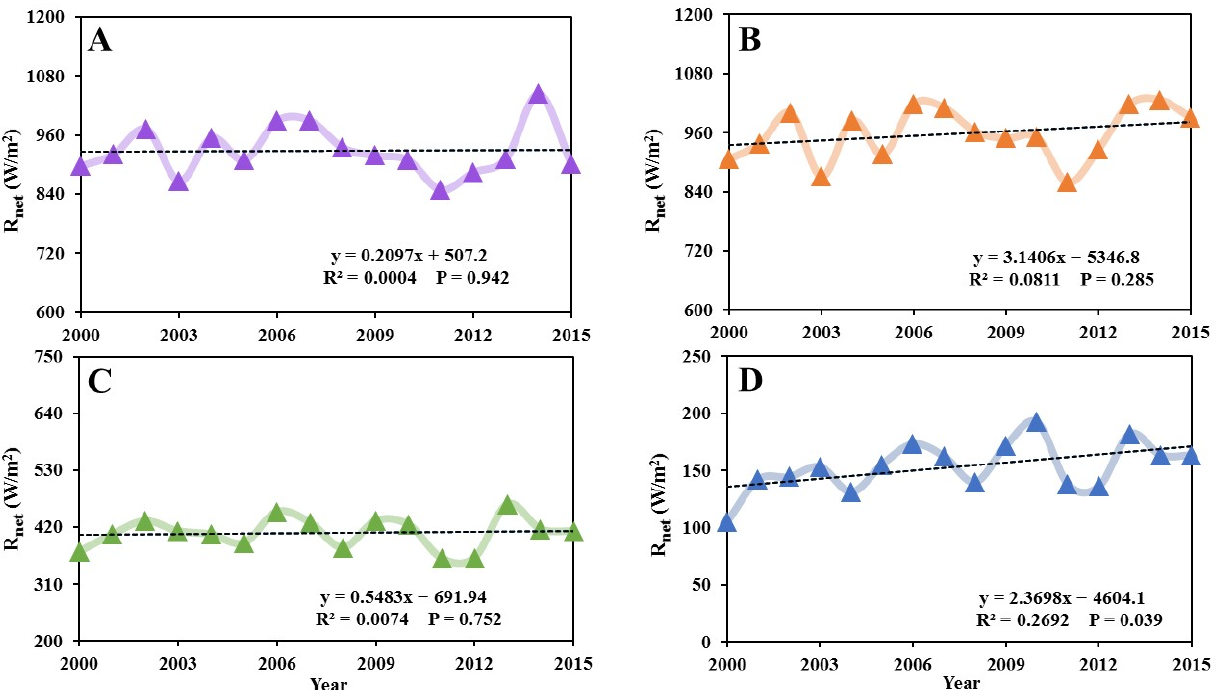
Figure 14. Trend of net radiation from 2000 to 2015 (( A ) Jinan City, ( B ) Zhengzhou City, ( C) Lanzhou City, ( D ) Xining City).